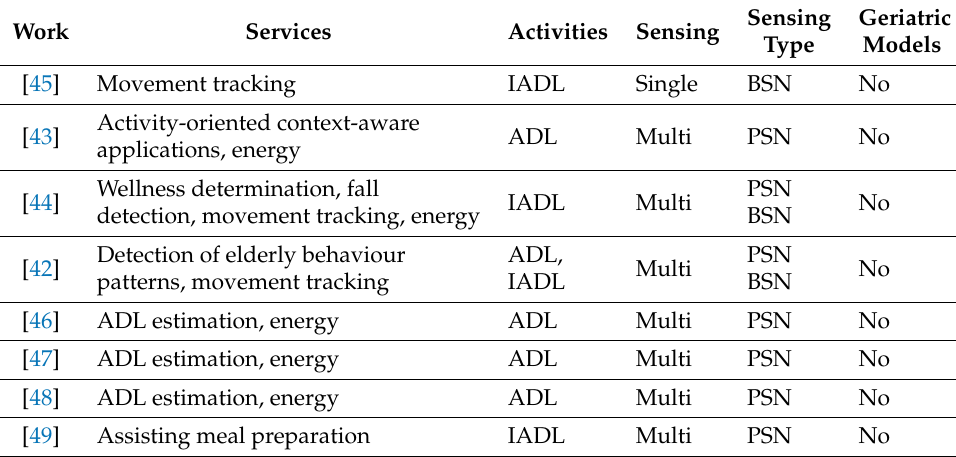
Table 3. Comparison among the most recent DSL approaches regarding ADLs.